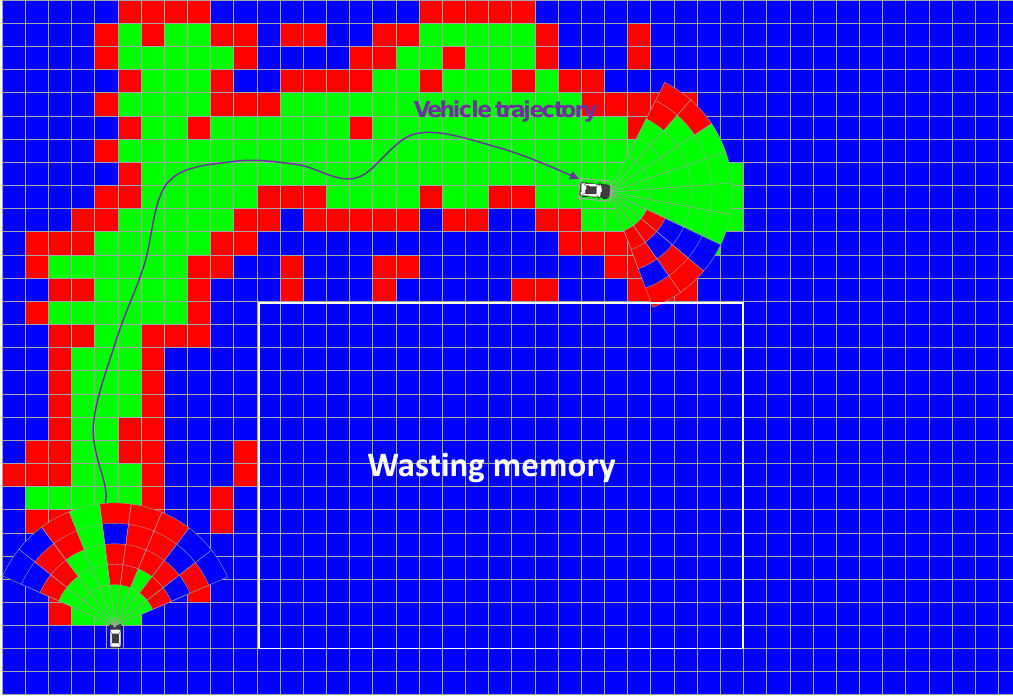
Figure 3. Mapping of Global EOGM based on the merging of local